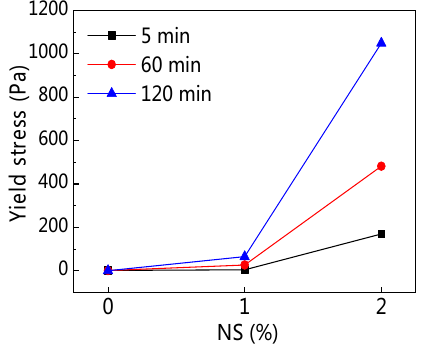
Figure 7. Influence of NS on yield stress ( τ 0 ).